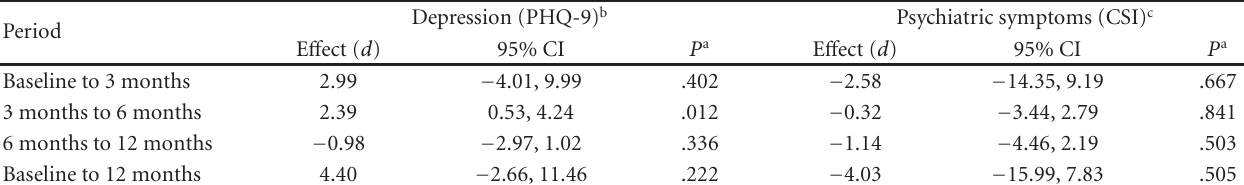
Table 2: Average treatment e ff ects for patients receiving an advanced practice psychiatric nurse